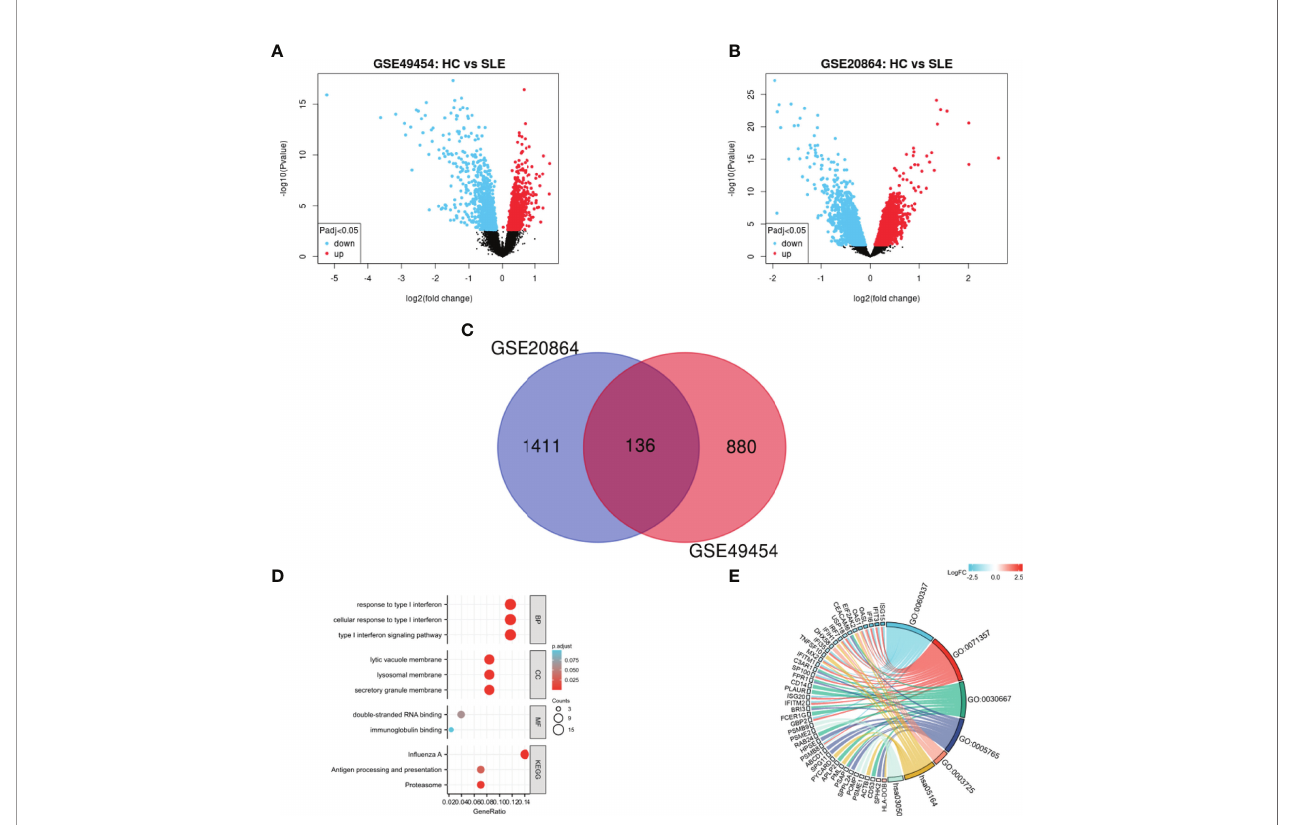
FIGURE 1 | Identi fi cation and functional enrichment of DEGs. (A) Volcano plot of GSE49454, (B) Volcano plot of GSE20864, and (C) Venn diagram of common DEGs from the two datasets. Red and blue data points represent the upregulated and downregulated genes, respectively. (D) Histogram and (E) chordal graph of GO enrichment and KEGG pathway analysis of the overlapping